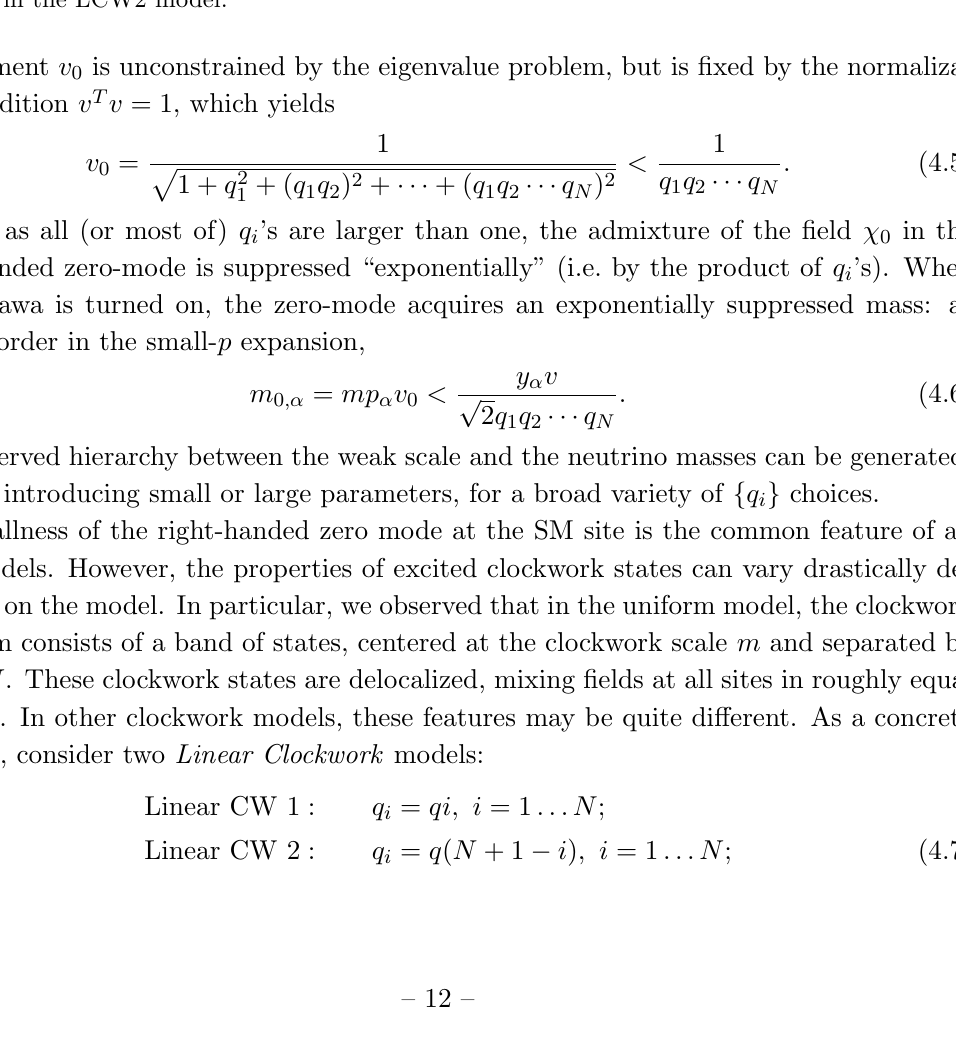
Figure 5 . Composition of the left-handed (left panel) and right-handed (right panel) mass eigen- modes in terms of the original clockwork (cid:12)elds in the Linear CW 1 model (top line) and Linear CW 2 model (bottom line). In both cases, N = 15, m = v , and y = 0 : 01; q = 0 : 76 in the LCW1 model and 0 : 73 in the LCW2